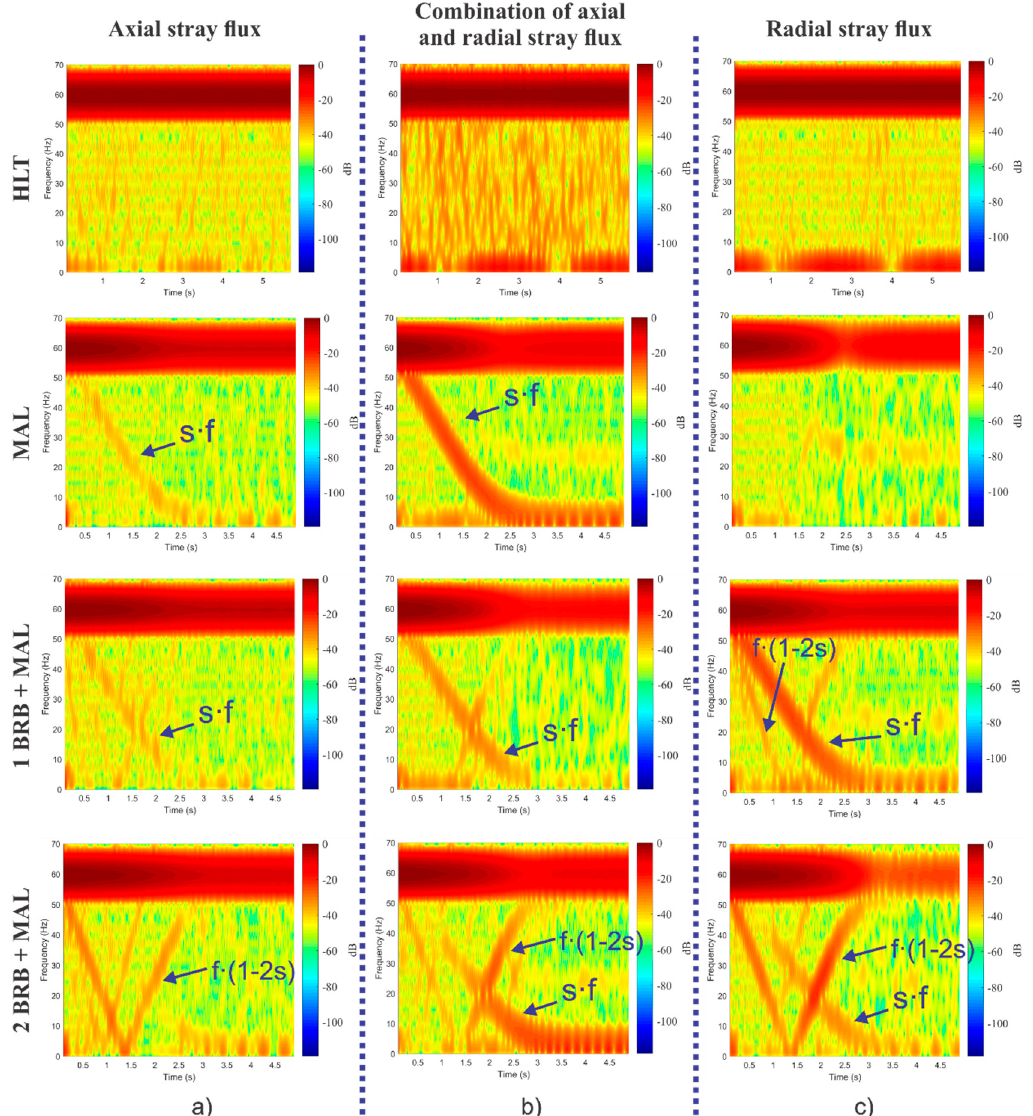
Figure 14. STFT analyses obtained for each one of the induction motor faults studied here when processing the signals provided by the triaxial stray flux sensor when installing it in position A: ( a ) primary sensor 2; ( b ) primary sensor 1; and ( c ) primary sensor 3.